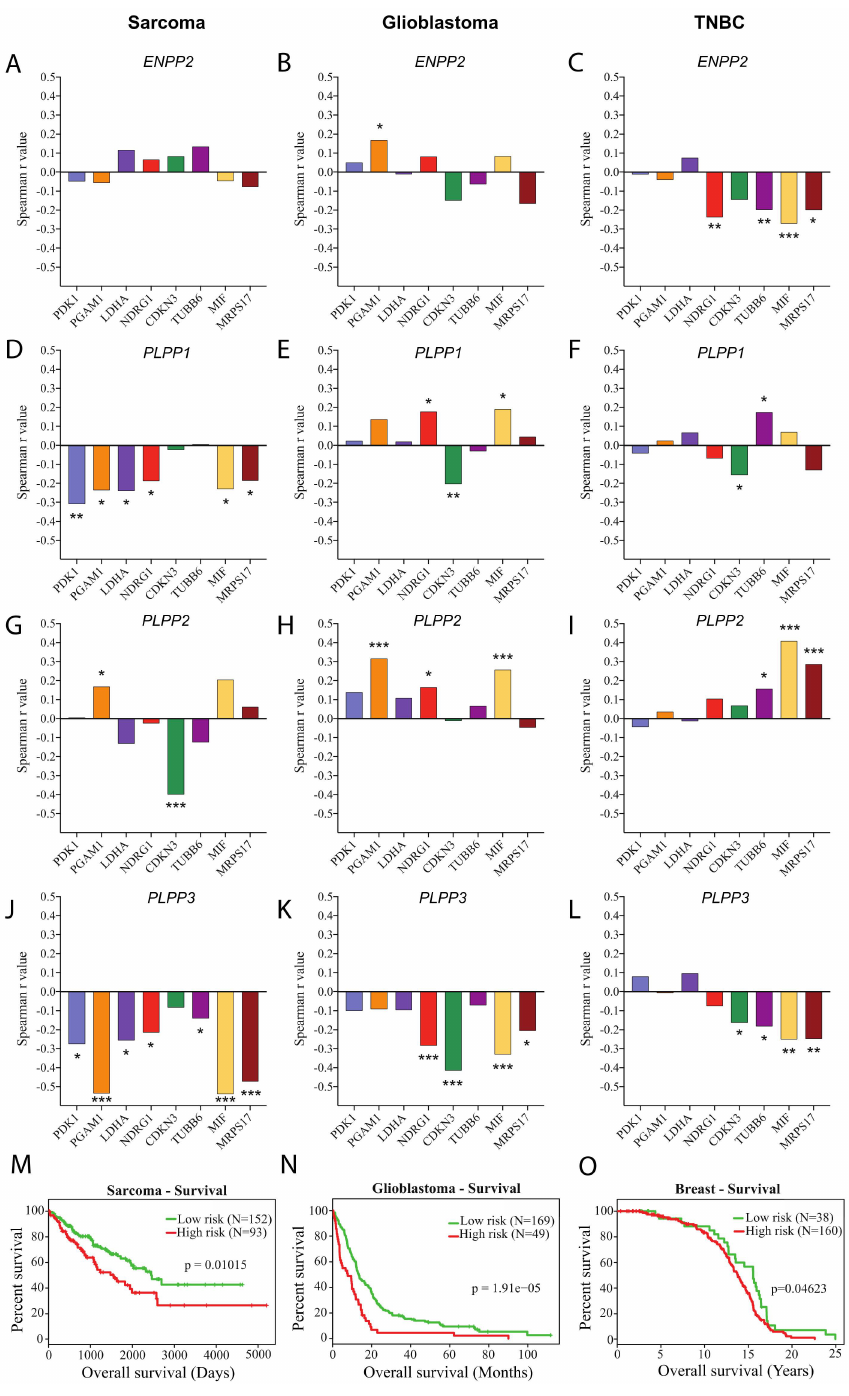
Figure 2. Correlation between ATX and LPP gene expression with a hypoxia gene signature and risk of mortality in patient cohorts. TCGA RNAseq data was used to measure Spearman r correlation coe ffi cient of ( A – C ) ENPP2 (autotaxin), ( D – F ) PLPP1 (LPP1) , ( G – I ) PLPP2 (LPP2) or ( J – L ) PLPP3 (LPP3) RNA expression with hypoxia-induced genes in ( A , D , G , J ) fibroblastic sarcoma ( N = 86), ( B , E , H , I ) glioblastoma ( N = 166), or ( C , F , I , L ) basal breast cancer ( N = 171) tumor tissue from patient cohorts. (* p < 0.05, ** p < 0.01, *** p < 0.001). ( M – O ) Kaplan-Meier plots obtained using the SurvExpress online software showing overall survival curves of high- and low-prognostic risk groups based on PLPP3 expression in sarcoma (M), glioblastoma (N) and breast (O) cancer patients cohorts. Log-rank test p -values are